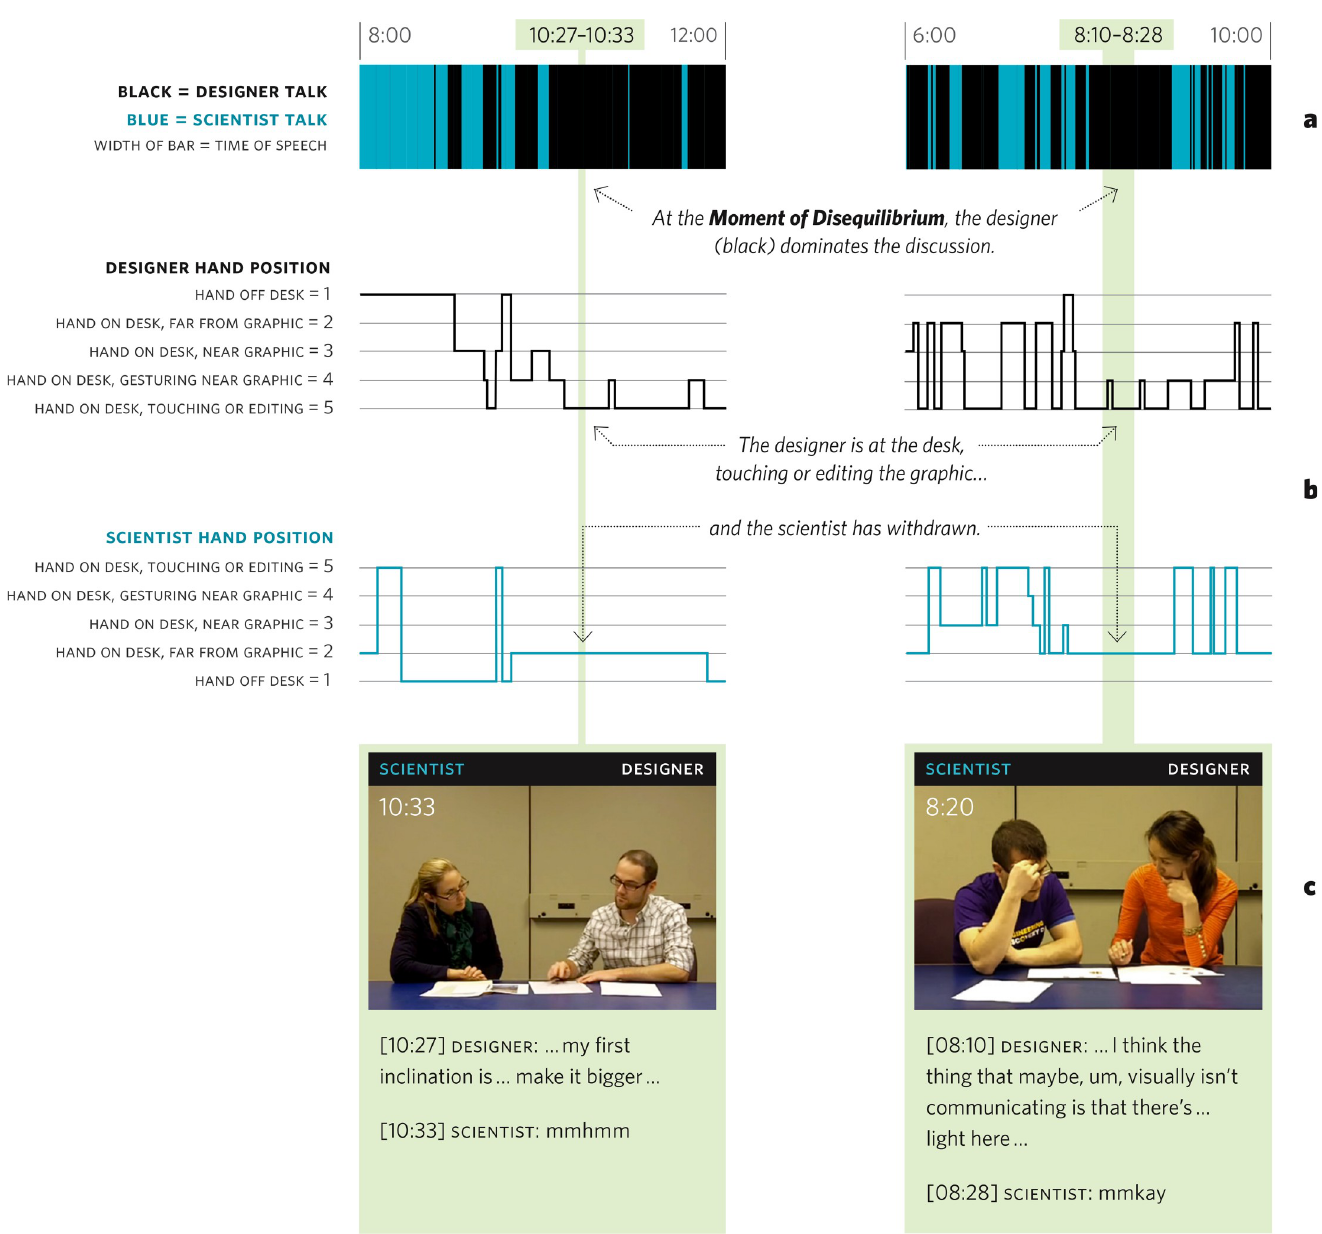
Fig 3. A closer look at the ‘moment of disequilibrium’. Two instances of disequilibrium characterized by (a) who is speaking, (b) hand position, and (c) body language. In (a) designer and scientist utterances/turn-taking are shown in a bar chart. In (b) hand positions are mapped, with higher numbers indicating closer proximity to the desk and graphic. Both (a) and (b) show the scientist withdrawing verbally and physically during disequilibrium. In (c) both scientists exhibit the discomfort of disequilibrium (clasped hands and crossed arms are known signals of